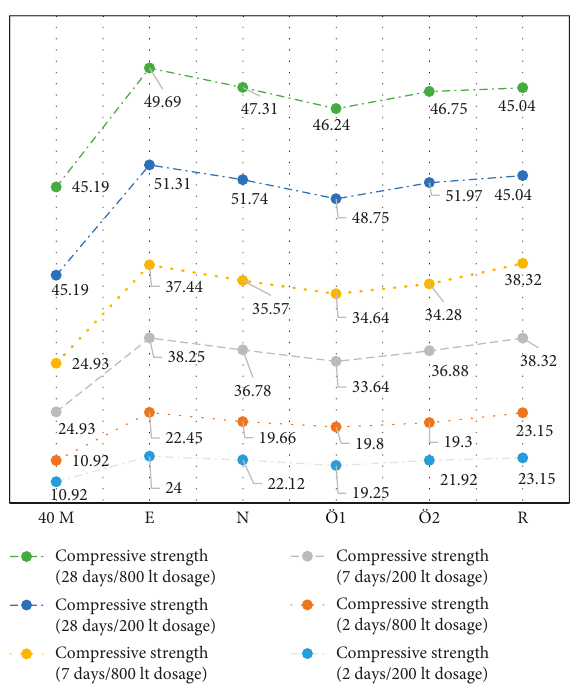
Figure 3: Effect of cement chemical additive dosage on com- pressive